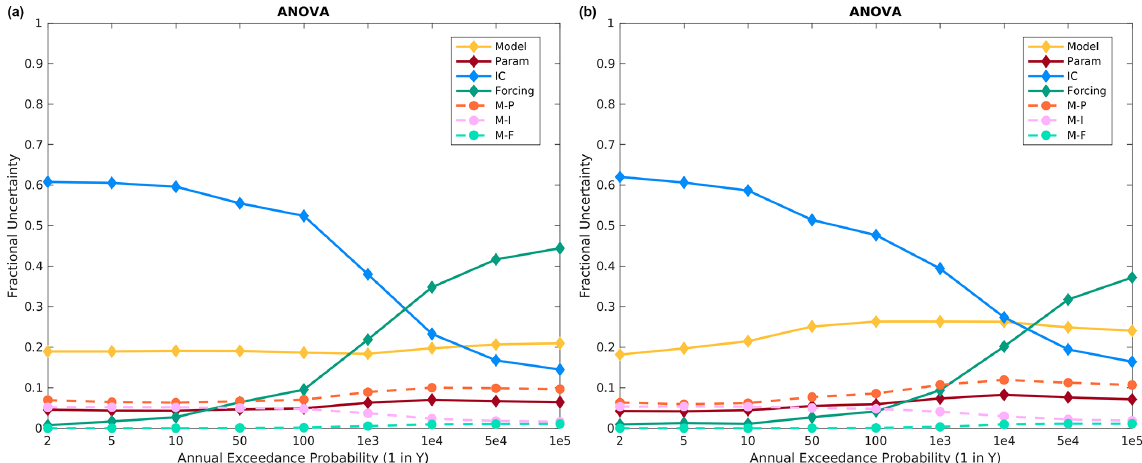
Figure 8. Island Park fractional variance contributions using all 10 model structures for the (a) specified meteorological sequence and (b) historical meteorological sequence. Only interaction terms that contribute significant variance are shown in Figs.